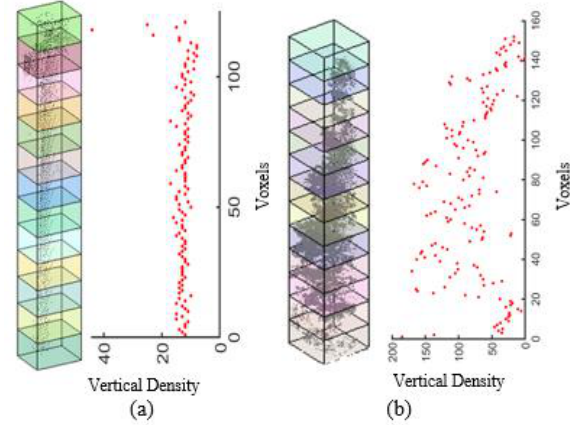
Figure 12. Illustrating diagram of vertical density of a pole and non-pole object. (a) Vertical density of a pole object. (b) Vertical density of a non-pole object.